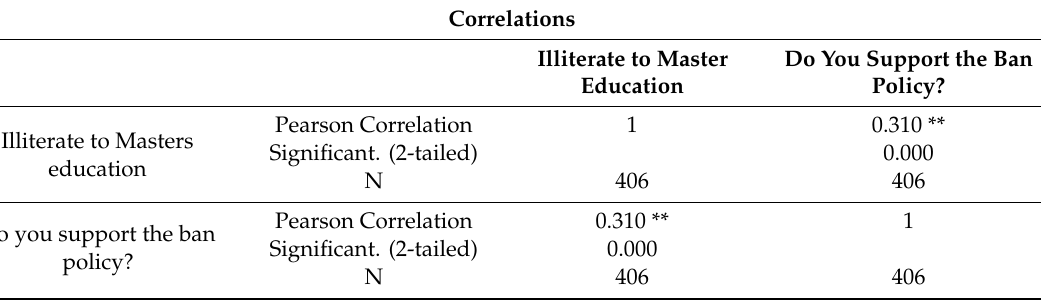
Table A14. Education correlations